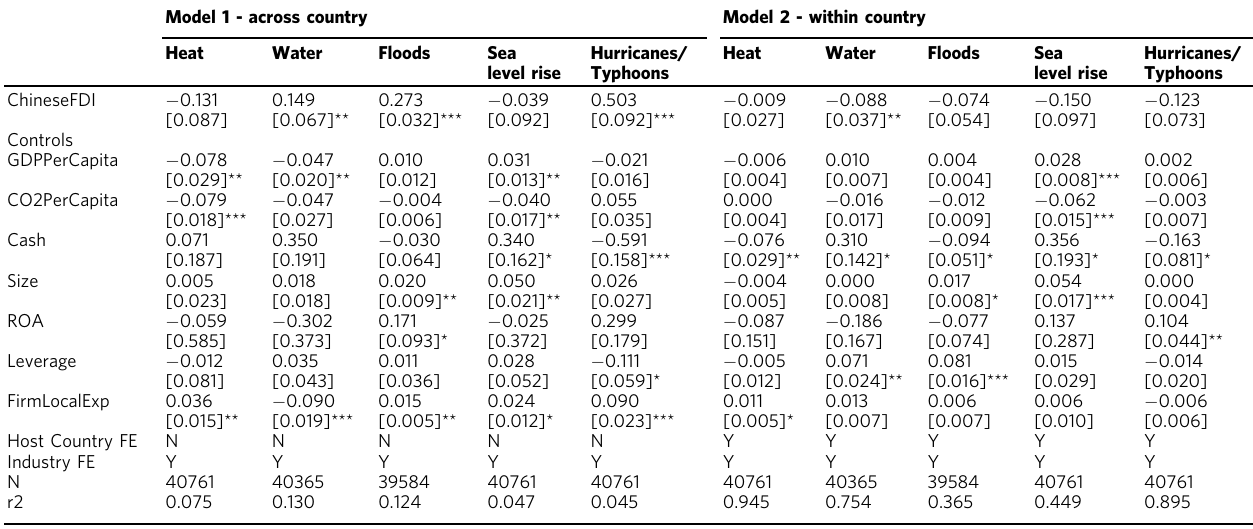
The unit of analysis is fi rm-host country-industry. Standard errors are clustered at the industry level. Outcome variables are climate risk scores and are standardized to a mean of 0 and a standard deviation of 1. GDPPerCapita, CO2PerCatpita, and FirmLocalExperience are also standardized for easy